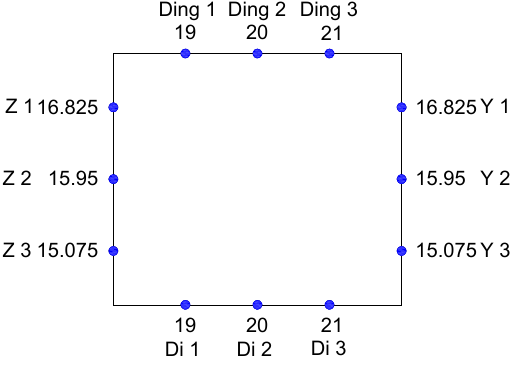
Figure 10. Layout of roadway surface monitoring points.